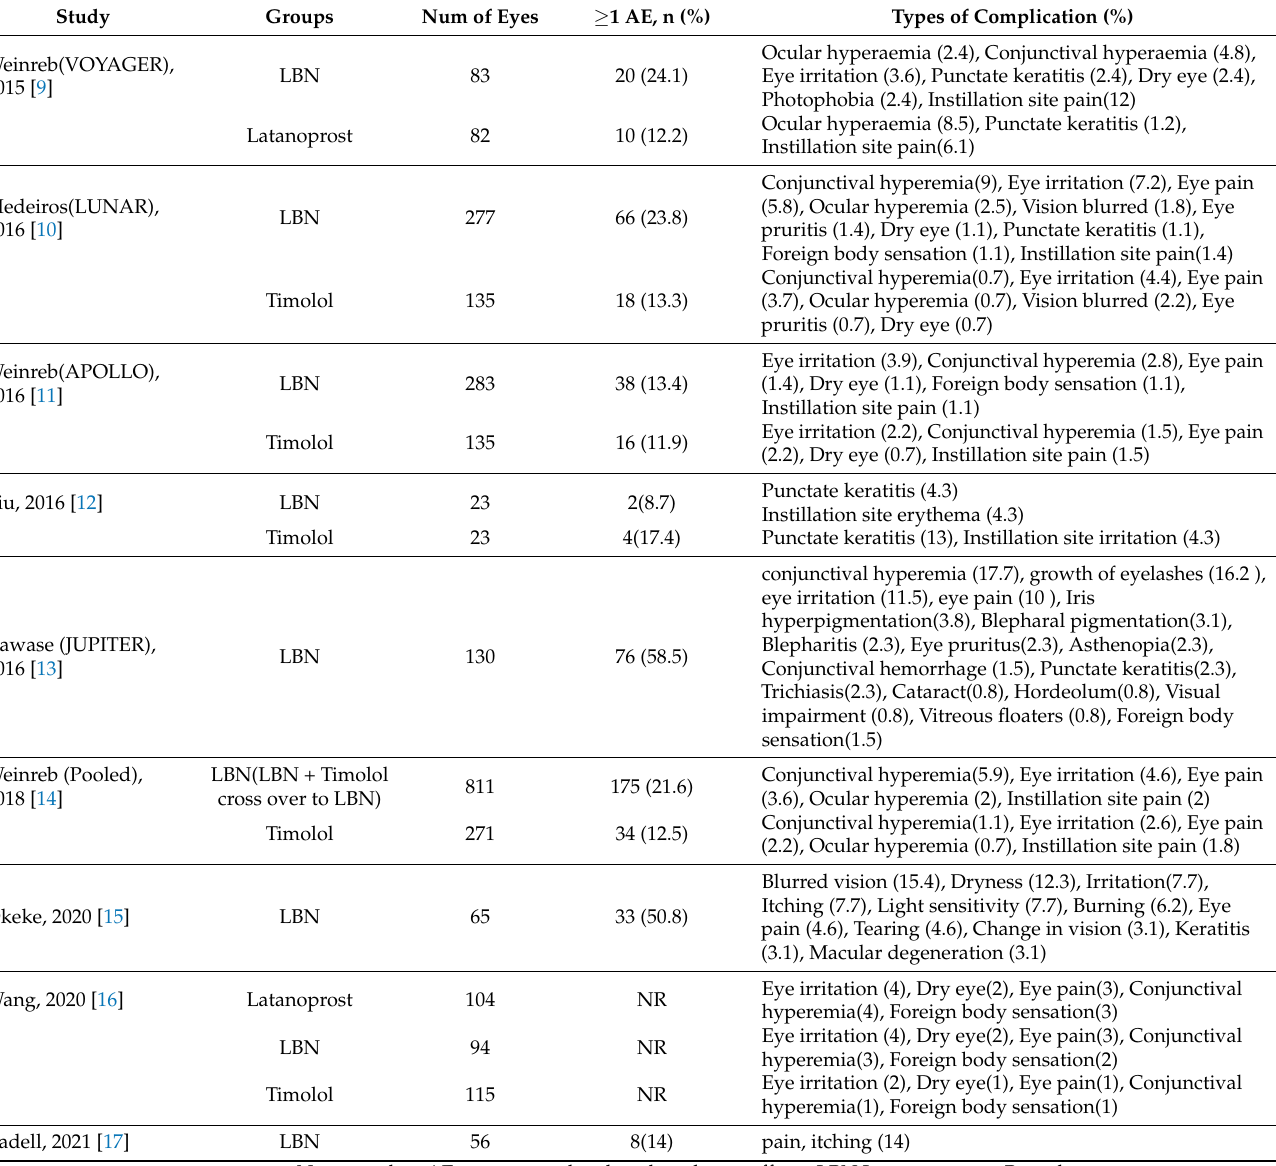
Table 3. Treatment-related ocular adverse effects in studies included in